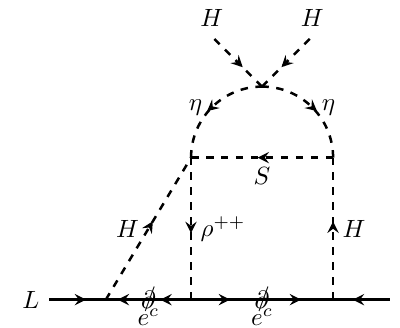
(cid:22) couples with a derivative to the with i